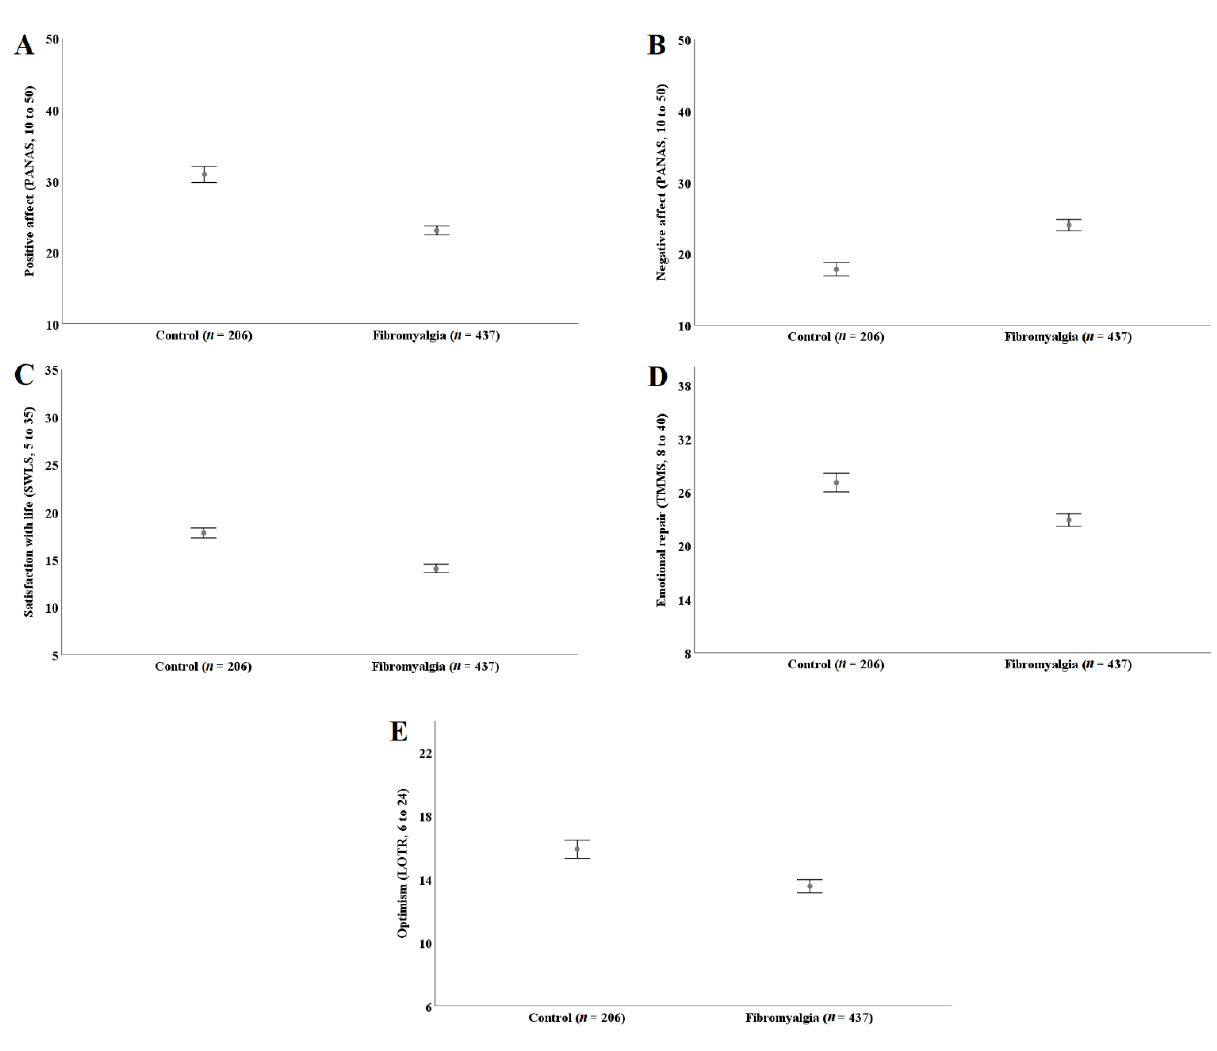
Figure 2. Panel ( A – E ): Levels of positive affect, negative affect, satisfaction with life, emotional repair and optimism in women with and without fibromyalgia. PANAS: Positive and Negative Affect Schedule. SWLS: Satisfaction with Life Scale. TMMS: Trait Meta-Mood Scale. LOT-R: Life Orientation Test-Revised.